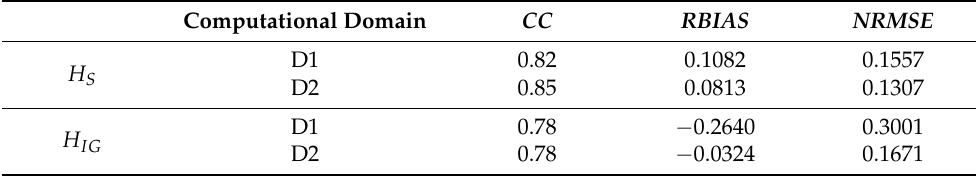
Table 3. Performance statistics for D1 and